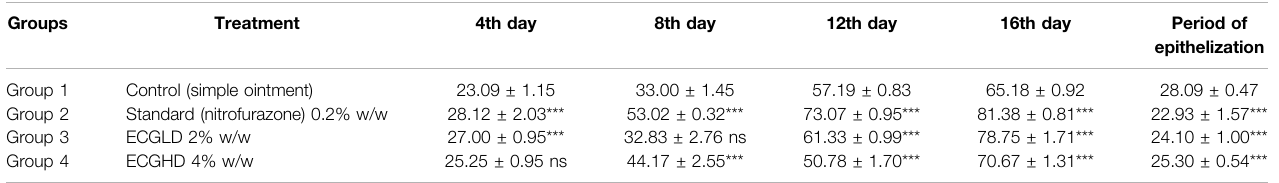
TABLE 5 | Effect of topical application of an ointment containing ethanolic leaf extract of C. gigantea leaves on wound contraction of the burn wound. Mean percentage of wound contraction ± SEM. Groups